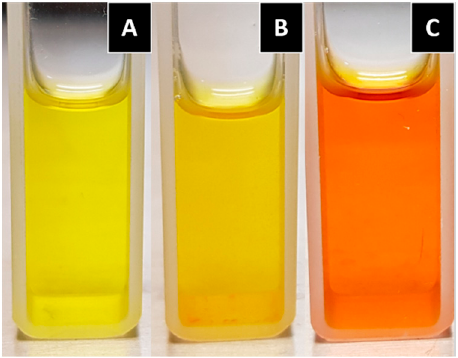
Figure 3. Curcumin dissolved in different mediums. ( A ) Curcumin in an acidic solution (pH 3.5); and ( B ) curcumin in a neutral solution (pH 7.4); both with the addition of 1% Tween 80 in order to increase solubility. ( C ) Curcumin in a basic solution (pH 12).